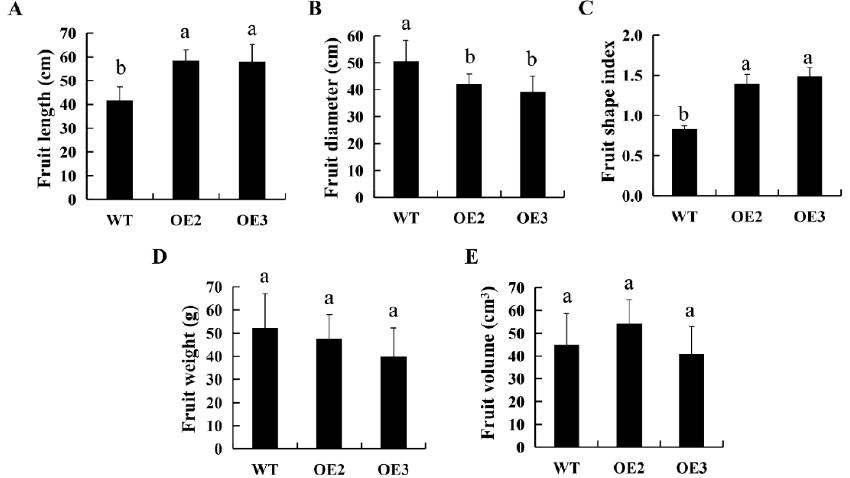
Figure 4. Variations in phenotypic parameters of tomato fruits between wild type plants and transgenic lines. ( A – E ) Comparison of fruit length ( A ), fruit diameter ( B ), fruit shape ( C ), fruit weight ( D ), and fruit volume ( E ) between wild type (WT) plants and two transgenic lines OE2 and OE3. Fruits from WT, OE2, and OE3 at 60 days after anthesis were used for determination of phenotypic parameters. Data are displayed as mean ± standard deviation of 50 fruit samples. Different lower letters indicate significant differences at the statistical level of 0.05 (unpaired two-tailed t -test).